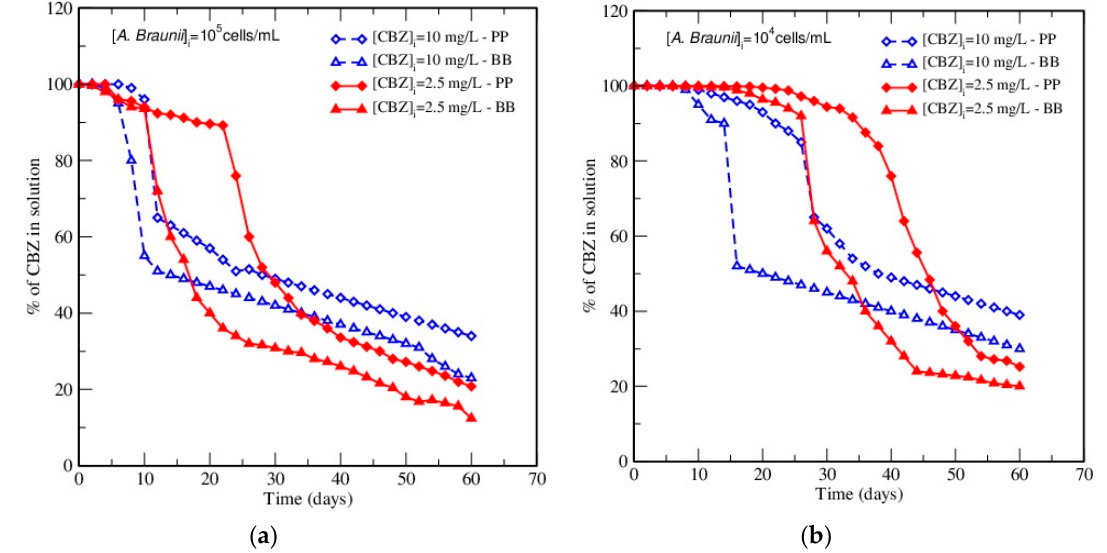
Figure 4. Effect of CBZ initial concentration on the elimination of CBZ at initial A. braunii content: ( a ) 10 5 cells/mL, and ( b ) 10 4 cells/mL.